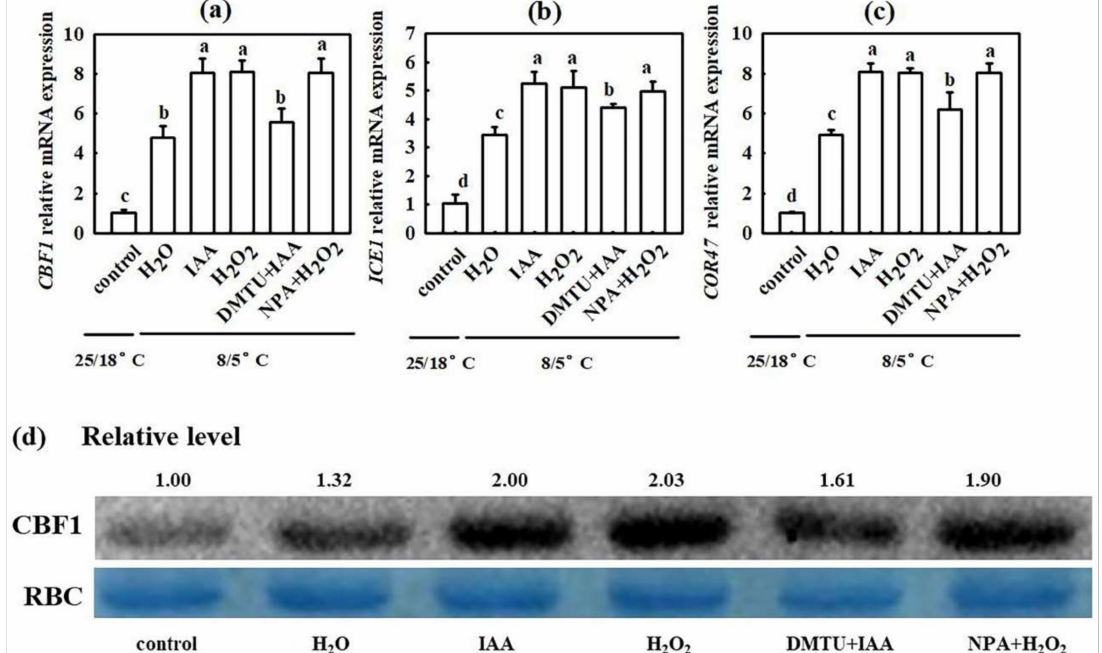
Figure 5. Interactive effects of IAA and H 2 O 2 on the level of cold responsive genes in cucumber seedlings under chilling stress. ( a – c ) mRNA abundances of CBF1 , ICE1, and COR47, respectively; ( d ) CBF1 protein level. Cucumber seedlings were pretreated with 75 µ M IAA, 1.0 mM H 2 O 2 , 5.0 mM DMTU +75 µ M IAA, 50 µ M NPA +1.0 mM H 2 O 2 , or deionized water (control) for 24 h and subsequently exposed to 5 ◦ C for 24 h. The data represent the mean ± SD of three biological replicates. Different letters indicate significant differences ( p < 0.05), according to Duncan’s new multiple range